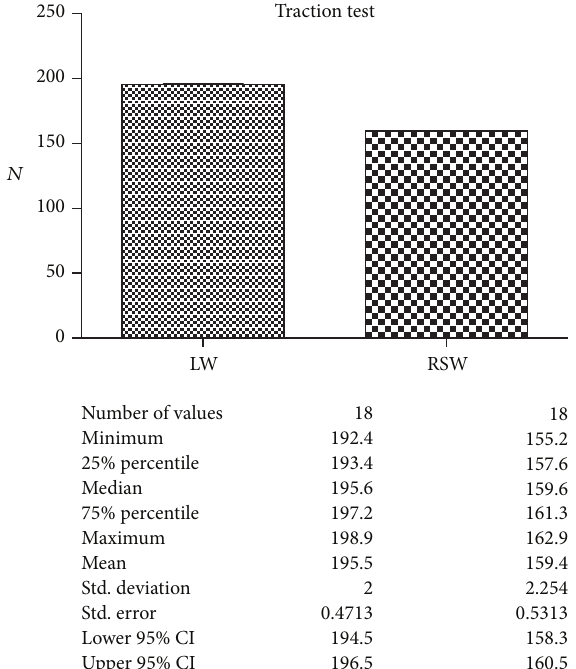
Figure 11: Comparison of the strength in the two groups. Descrip- tion of the statistical analysis used is shown